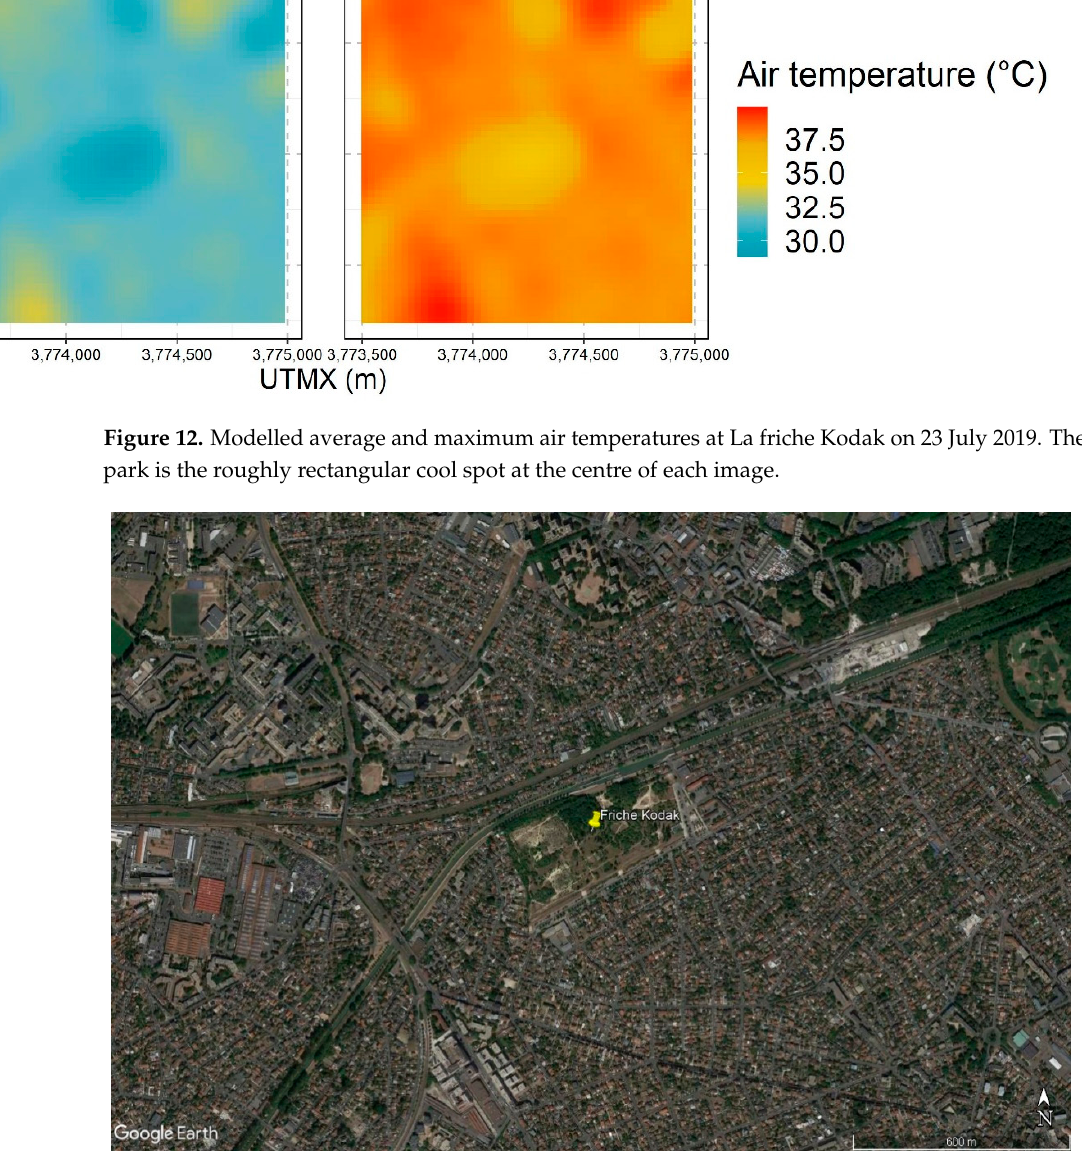
Figure 13. Google Earth Image of La friche Kodak (48°55’53.90” N, 2°31’31.40” E) and surrounding land on 8/6/20 12:00 AM. Eye alt 2.37 km. Note: the scale of this image is approximately half that of Figure 12. The east-west extent of the image is roughly 3000 m.